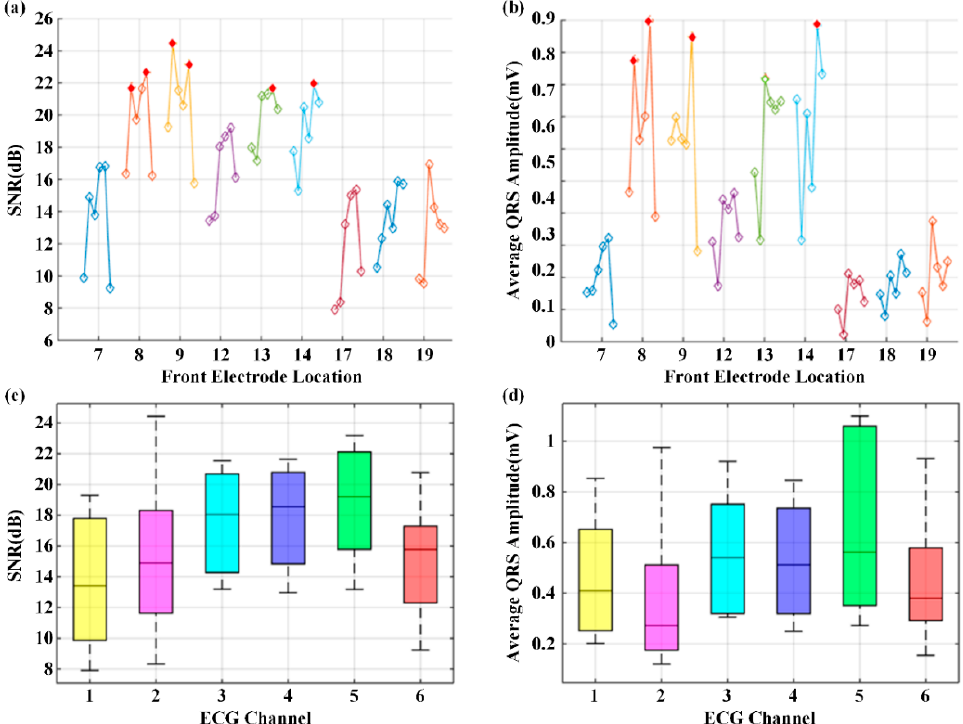
Figure 14. The results of the optimal location and orientation determination: ( a ) Average SNR value;